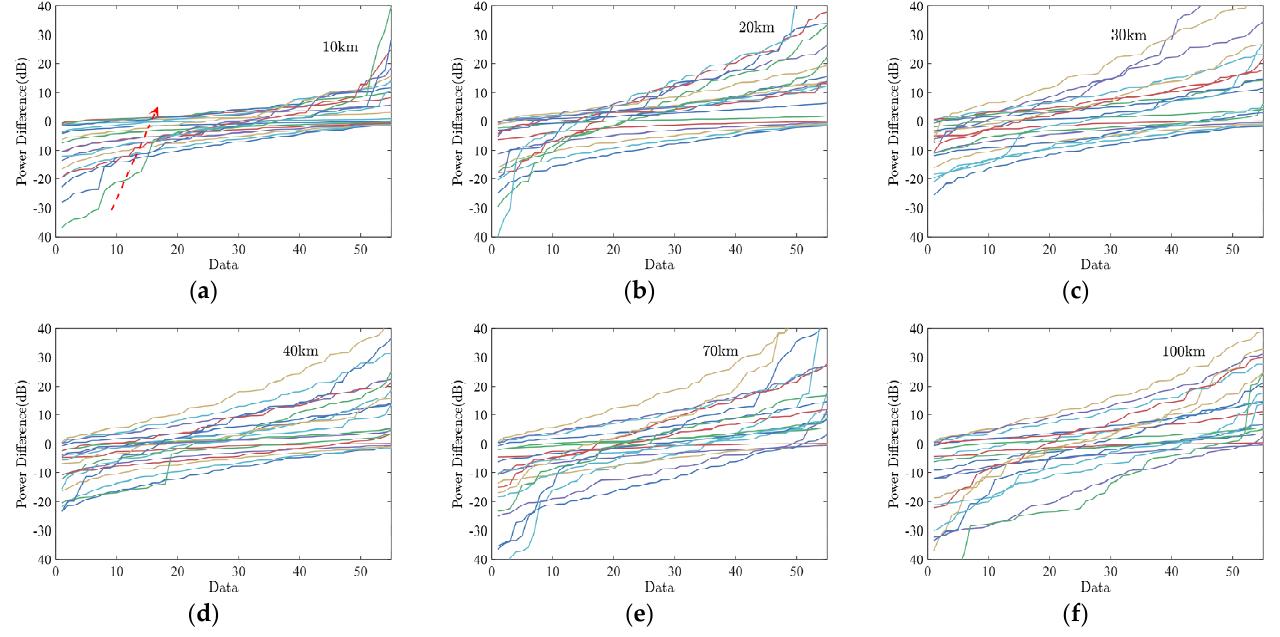
Figure 8. Target echo data at different locations on the sea surface for different EDHs. Sea surface target position at: ( a ) 10 km; ( b ) 20 km; ( c ) 30 km; ( d ) 40 km; ( e ) 70 km; ( f ) 100 km.